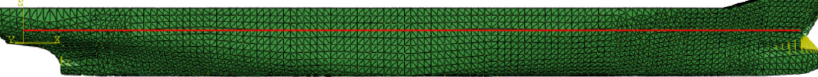
Figure 4. Finite Element calculation model.